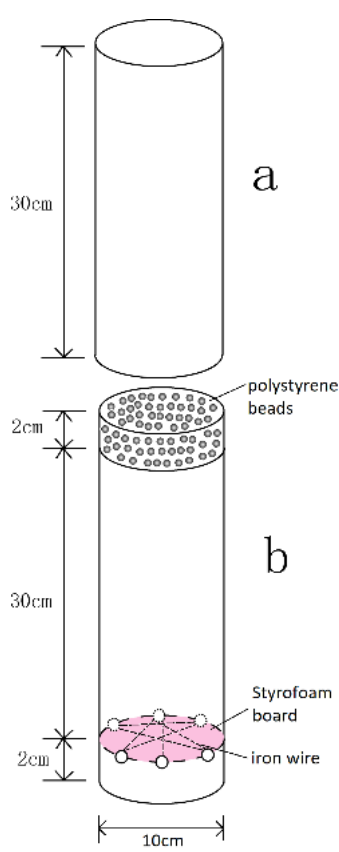
Figure 1. Schematic illustration of the vertical split-root growth system used in this study. Two 10 cm diameter polyvinyl chloride (PVC) tubes were stacked together and sealed with the tape. Holes were drilled 2 cm above the base of the lower tube and iron wires were knitted to form a net supporting a 1 cm-thick Styrofoam board with the soil on the top. The soil in the upper ( a ) and lower ( b ) tubes was separated by a 2 cm-thick layer of polystyrene beads to prevent upward water movement in the soil from the lower to the upper tube segment.